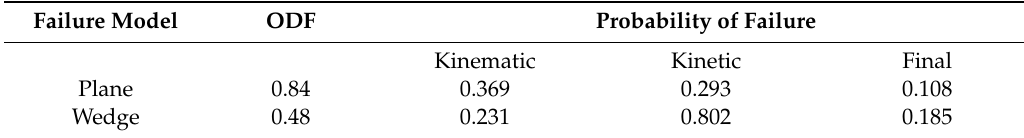
Table 4. Comparison of results for the deterministic probabilistic analysis of plane and wedge failures.